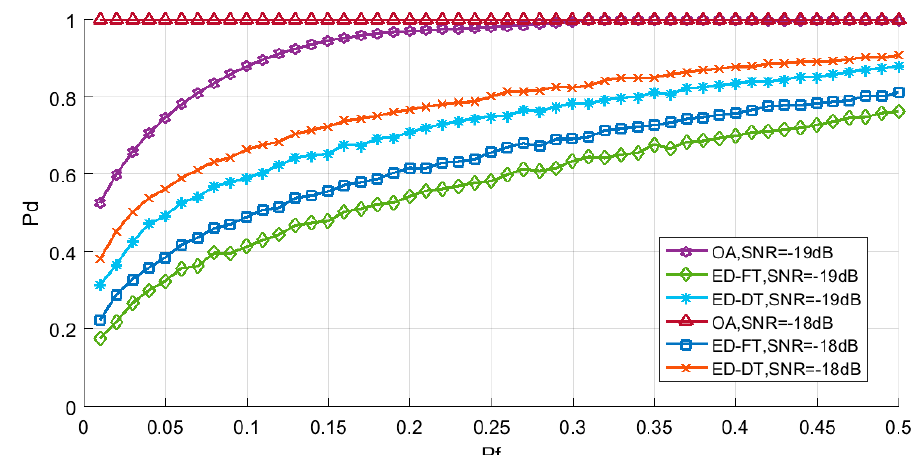
Figure 13. Comparison of the receiver operating characteristic (ROC) curve between the MRSSE algorithm and traditional spectrum sensing algorithms (OA: MRSSE algorithm; ED-FT: the energy detection algorithm with fixed threshold; ED-DT: the energy detection algorithm with adaptive threshold) under different SNRs. Pd is probability of detection and Pf is probability of false alarm.